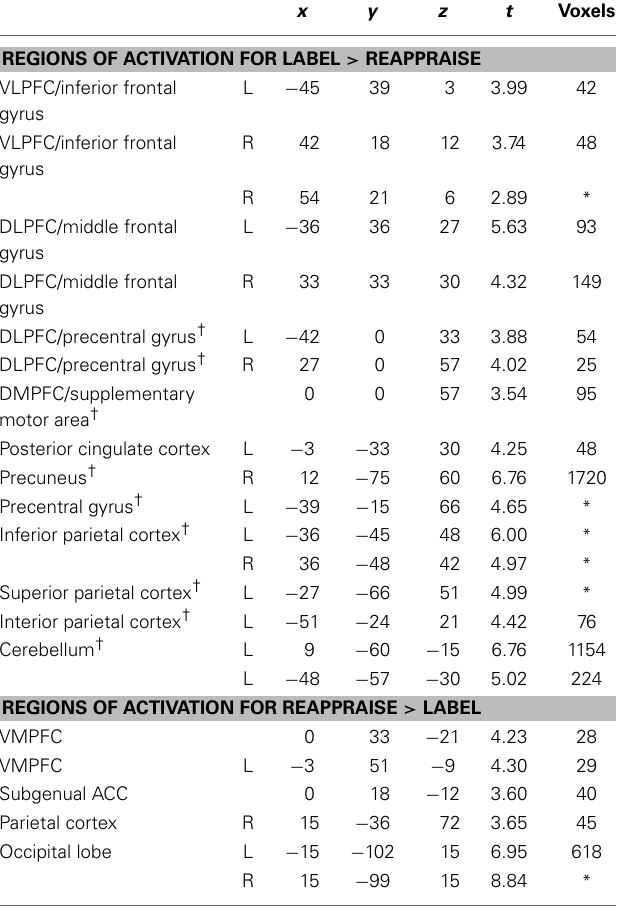
Table 2 | Differential activations for Labeling and Reappraising compared directly.